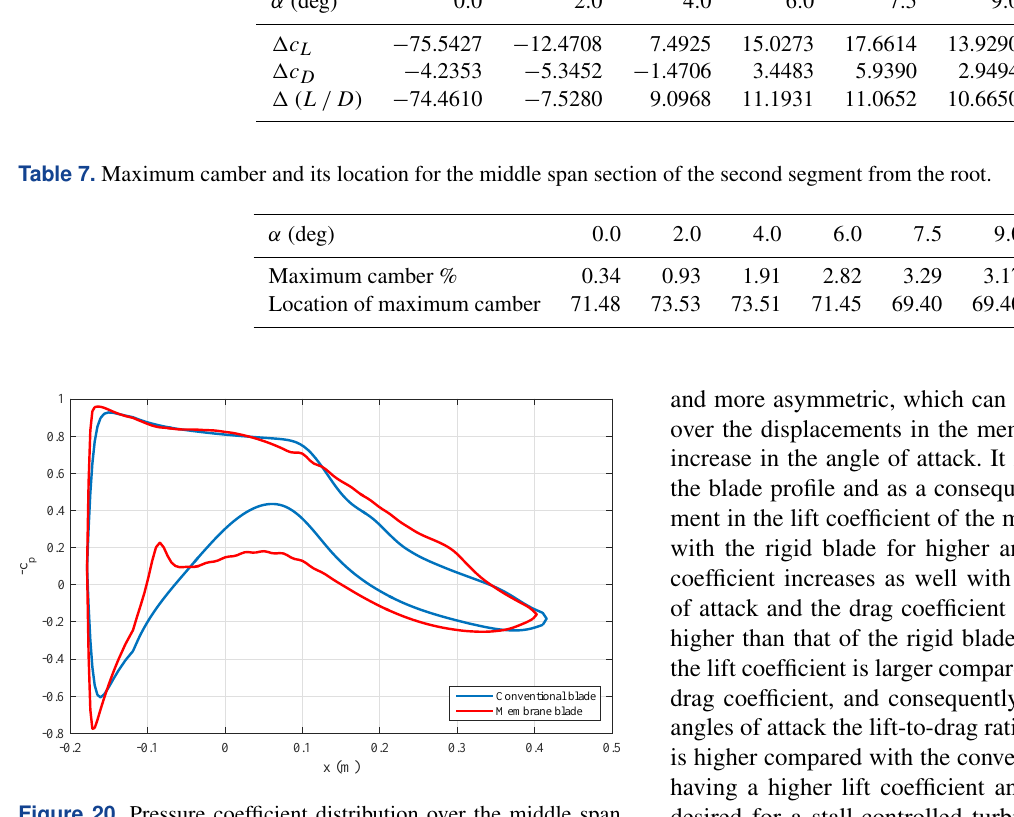
Figure 20. Pressure coefficient distribution over the middle span section of the second segment from the